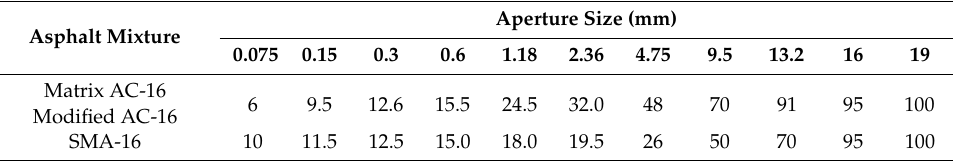
Table 2. Gradation of asphalt mixture (unit: